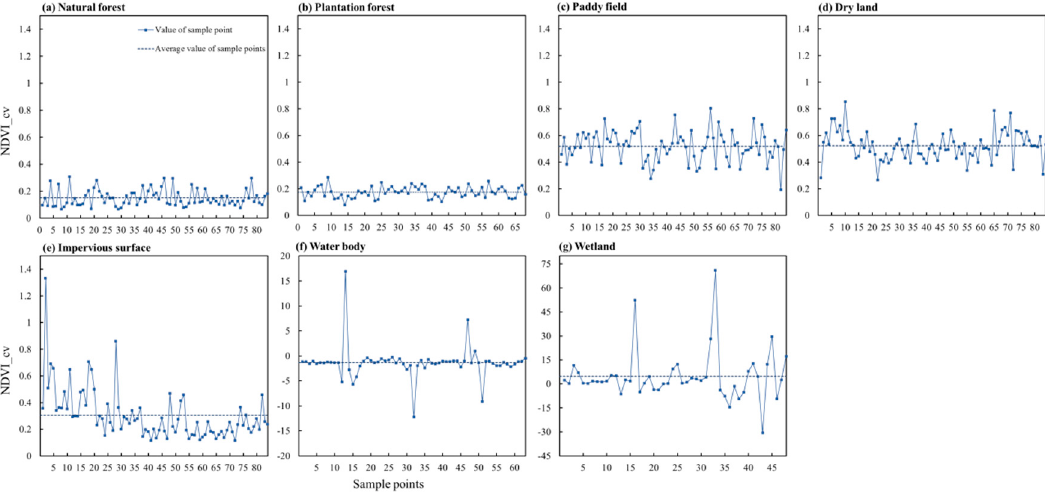
Figure 3. Coefficient of variation of the annual time-series NDVI (NDVI_cv) for ( a ) natural forest, ( b ) plantation forest, ( c ) paddy field, ( d ) dry land, ( e ) impervious surface, ( f ) water body, and ( g ) wetland.